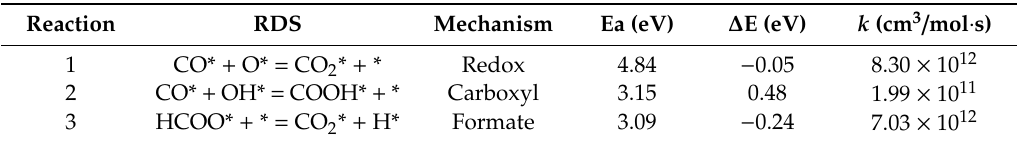
Table 12. Activation energy (Ea), reaction energy ( ∆ E) and rate constant ( k ) of rate determining steps (RDS) on Cu 3 -Pt 3 -Au(111), data from [160]. Reaction RDS Mechanism Ea (eV) ∆ E (eV) k (cm 3 / mol · s) 1 CO* + O* = CO 2 * + * Redox 4.84 − 0.05 8.30 × 10 12 CO* + OH* = COOH* + * Carboxyl 3.15 0.48 1.99 × 10 11 HCOO* + * = CO 2 * + H* Formate 3.09 * Indicates a vacant site. X* indicates the adsorbed X